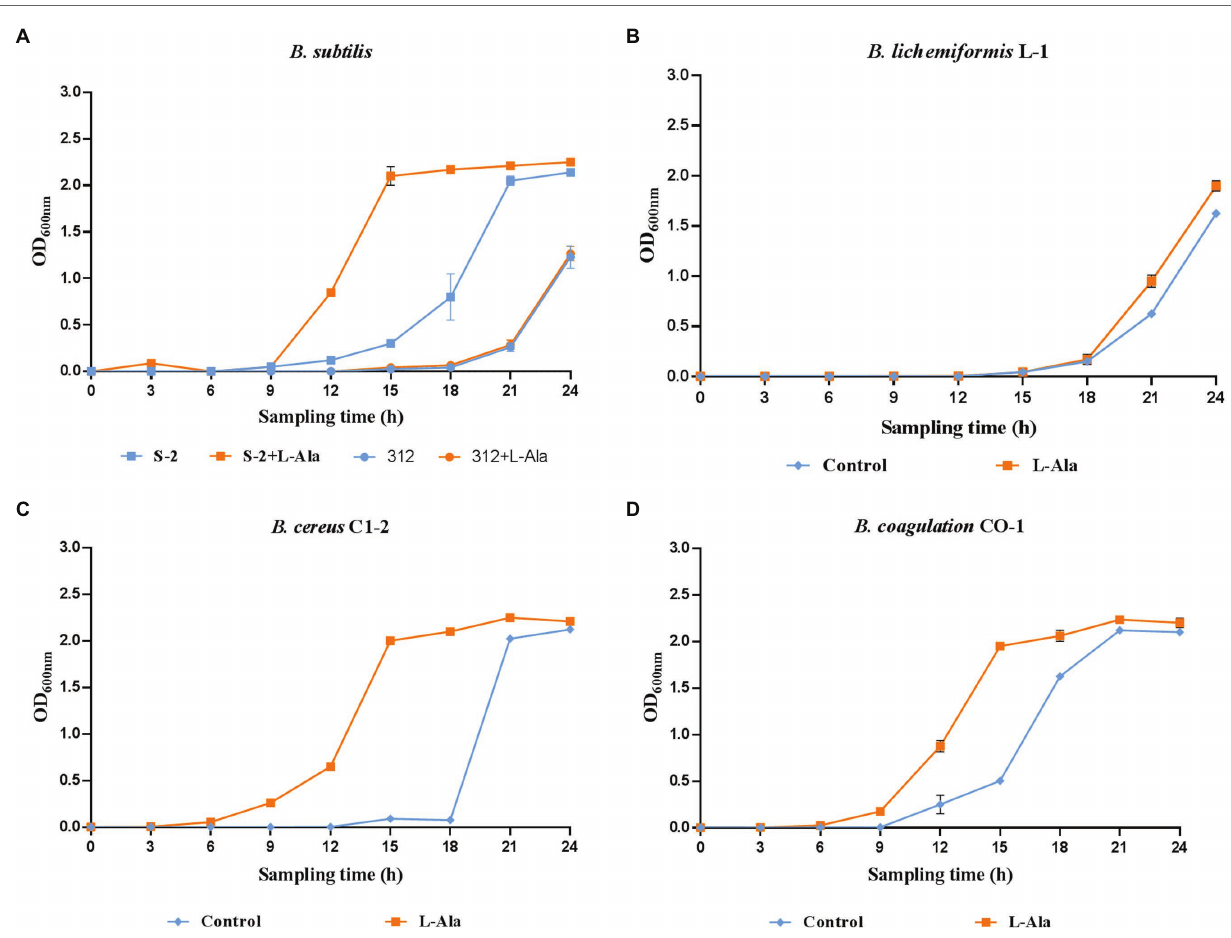
FIGURE 2 | The growth curves of (A) B. subtilis S-2/312, (B) B. lichemiformis L-1, (C) B. cereus C1-2, (D) B. coagulans CO-1 with or without L-alanine pre-